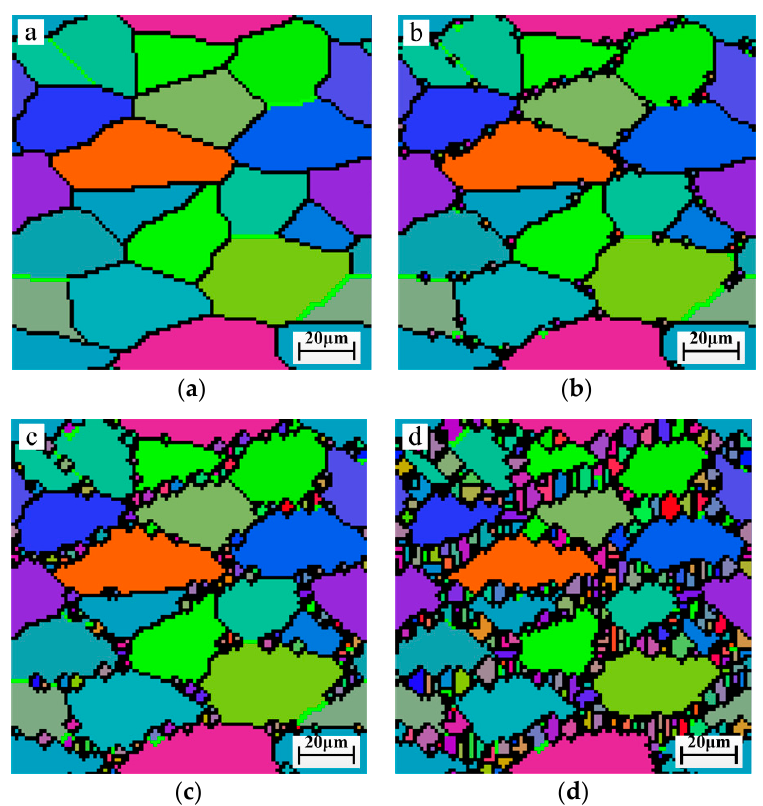
Figure 8. Microstructure evolution model under different pre-stress ( a ) pre-stress σ p = 0 MPa;